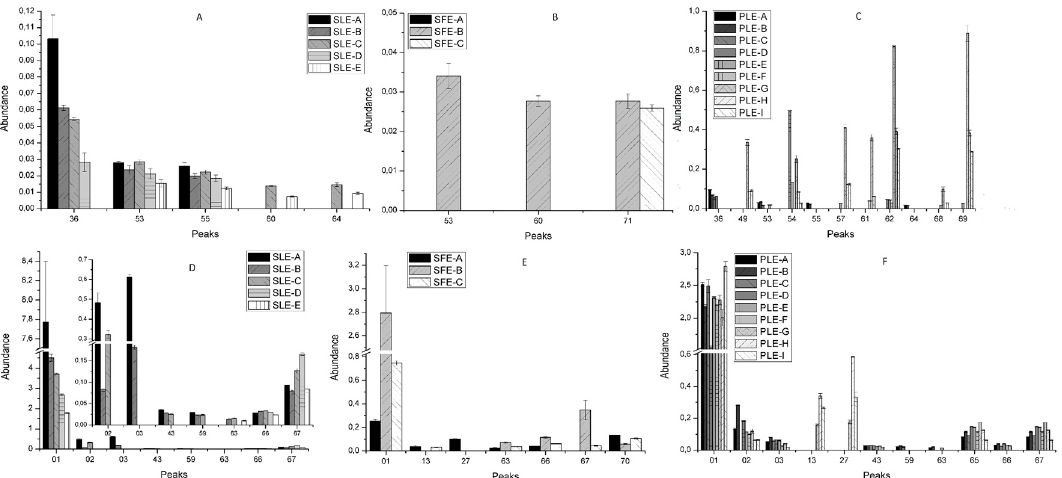
Figure 3. Abundance * of the different groups of compounds: non-derivatives flavan-3-ols Figure 3